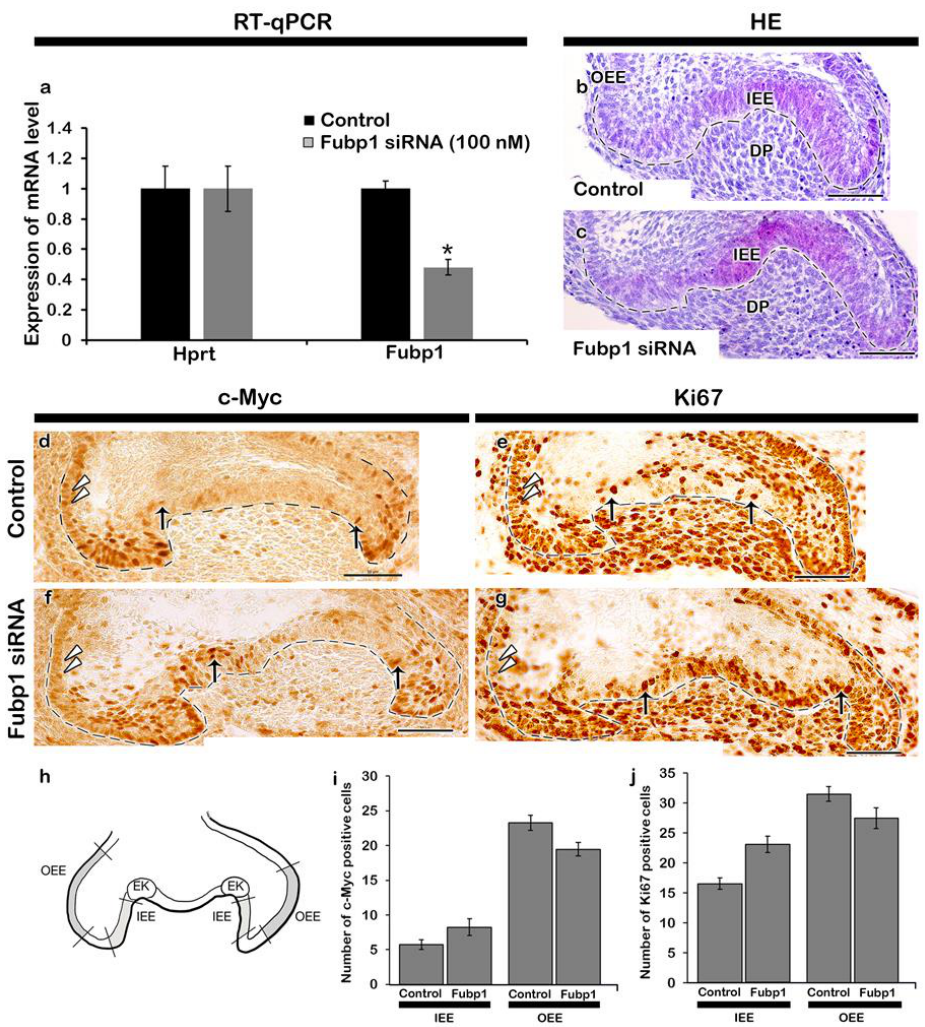
Figure 2. Altered c-Myc localization and cellular proliferation after Fubp1 knock-down. Fubp1 siRNA (100 nM) downregulates the expression of Fubp1 during in vitro organ cultivation at E14 for 1 day as determined by quantitative PCR ( a ). Hematoxylin and eosin staining of E14 + 2 control and Fubp1 siRNA-transfected tooth germ showing IEE and DP ( b , c ). Immunohistochemistry of c-Myc and Ki67 showing increased number of c-Myc and ki67 positive cells at IEE and decreased number of c-Myc and Ki67 cells at OEE in the Fubp1 knock-down specimen compared to control ( d – g ). Schematic diagram showing region of interest for cell count ( h ). Statistical analysis showing increased and decreased c-Myc and Ki67 positive cell numbers along the IEE and OEE respectively in the Fubp1 knock-down specimen ( i , j ). Arrows and arrowheads indicate c-Myc positive cells ( d , f ) and Ki67 positive cells ( e , g ). EK; enamel knot, IEE; inner enamel epithelium, OEE; outer enamel epithelium, DP; dental Papilla. Scale bars: 50 μm ( b – g ).